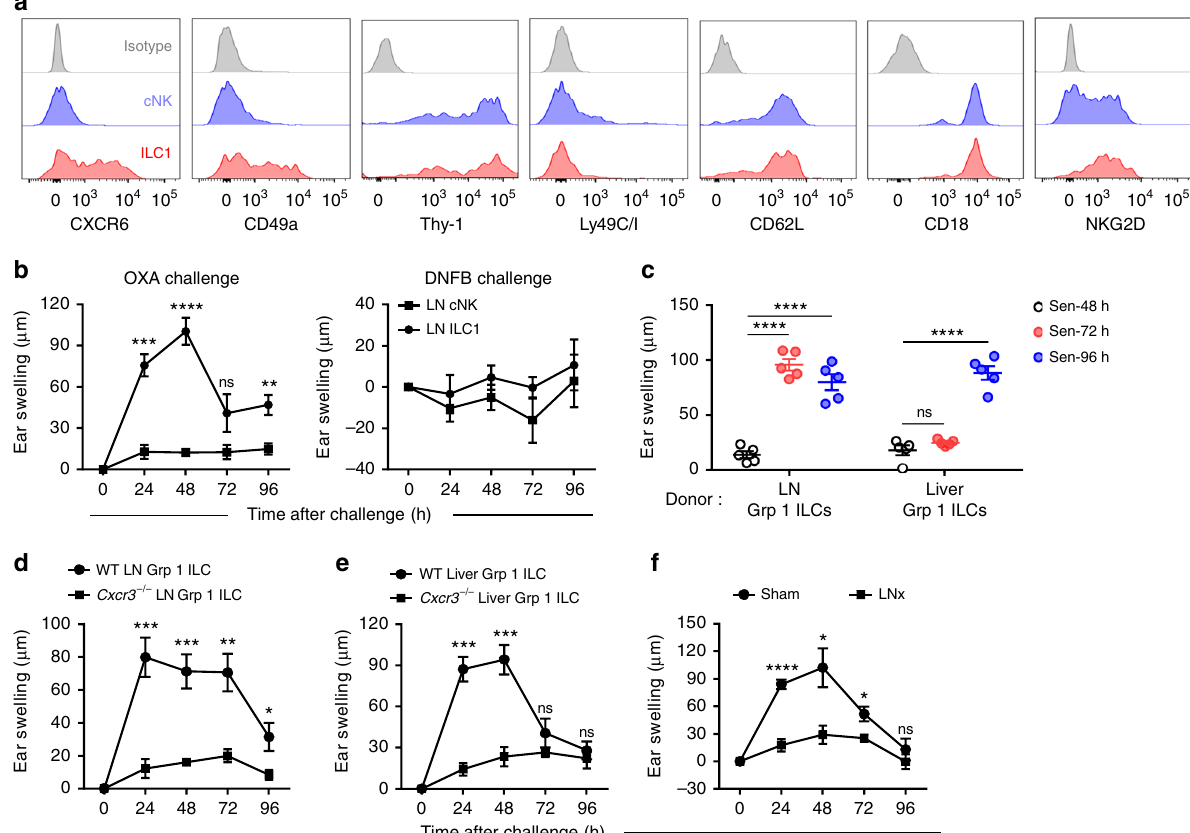
Fig. 4 Initial acquisition of immunological memory by IL-7R α + ILC1s occurs in skin-draining LNs. a Expression of CXCR6, CD49a, Thy-1, Ly49C/I, CD62L, CD18, and NKG2D on IL-7R α − cNK cells and IL-7R α + ILC1s from ILNs of OXA-sensitized (day 3) WT B6 mice. Data are representative of at least three independent experiments ( n = 3 – 5 in each experiment). b Ear swelling of WT B6 mice that received 5 × 10 4 skin-draining LN cNK cells or ILC1s from OXA- sensitized Rag1 − / − mice (day 4) and were challenged with OXA or DNFB 1 month later. Data are pooled from two independent experiments ( n = 4 – 5 in each group). c Ear swelling of WT B6 mice that received 2 × 10 5 skin-draining LN or liver group 1 ILCs from OXA-sensitized Rag1 − / − mice at different time points, followed by challenge with OXA 1 month later. Data are pooled from two independent experiments ( n = 5 in each group). d Ear swelling of WT B6 mice that received 2 × 10 5 skin-draining LN group 1 ILCs from OXA-sensitized (day 3) WT or Cxcr3 − / − mice and were challenged with OXA 1 month later. Data are pooled from two independent experiments ( n = 4 – 5 in each group). e Ear swelling of WT B6 mice that received 2 × 10 5 liver group 1 ILCs